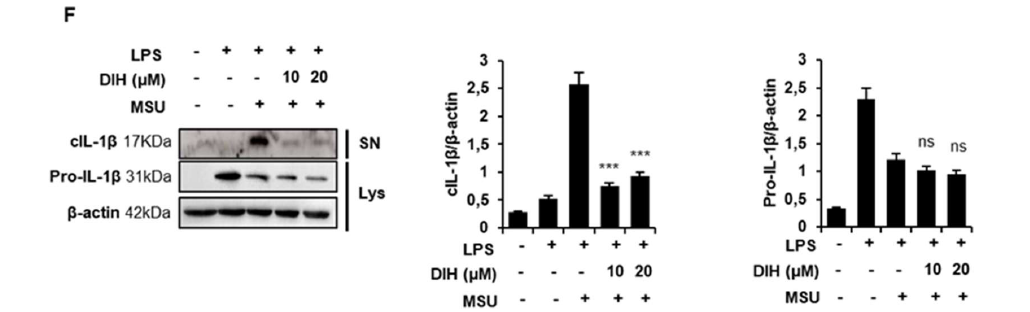
Figure 2. DIH reduces IL-1β secretion following NLRP3 inflammasome activation. ( A , D ) J774A.1 macrophages were primed for 4 h with LPS (1 μg/mL), followed by treatment with various doses of DIH (5, 10, 20, 50 μM) for 30 min and then Nig (20 μM) for 1 h. ( B , E ) LPS-primed macrophages were treated with 10 or 20 μM of DIH and then stimulated with ATP (5 mM, 30 min). ( C , F ) LPS-primed macrophages were treated with 10 or 20 μM of DIH and then stimulated with MSU (150 μg/mL, 24 h). ( A – C ) Levels of IL-1β in the culture medium were measured using ELISA. Results show the means ± SD of three independent experiments. ( D – F ) Supernatants (SN) and cell lysates (Lys) were analyzed by immunoblot of cleaved IL-1β (17 kDa) and pro-IL-1β (31 kDa) expression. β-actin was immunoblotted as a loading control. Densitometry analysis shows the mean ± SD of the western blot experiments. ns = not significant, ** p < 0.01 and *** p < 0.001 vs. LPS + stimuli (Nig, ATP or MSU).